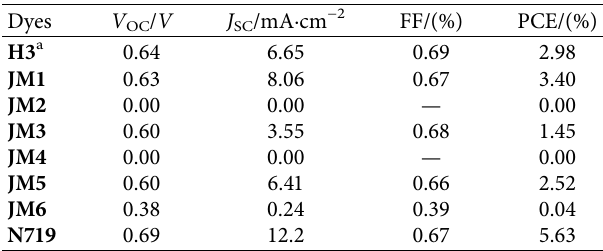
Figure 3: Photocurrent density-voltage ( J-V ) characteristic curves of JM1 – JM6 and N719 –sensitized TiO conditions of 1 sun (AM 1.5G). Electrolyte mediator: I 2 (0.05 M), LiI (0.5M), and tert -butylpyridine in acetonitrile (0.5M). Table 2: Photovoltaic parameters of the DSSCs sensitized using H3 , JM1–JM6 , and N719 dyes under the 1 sun (AM 1.5G, 100mW · cm − 2 ) illumination